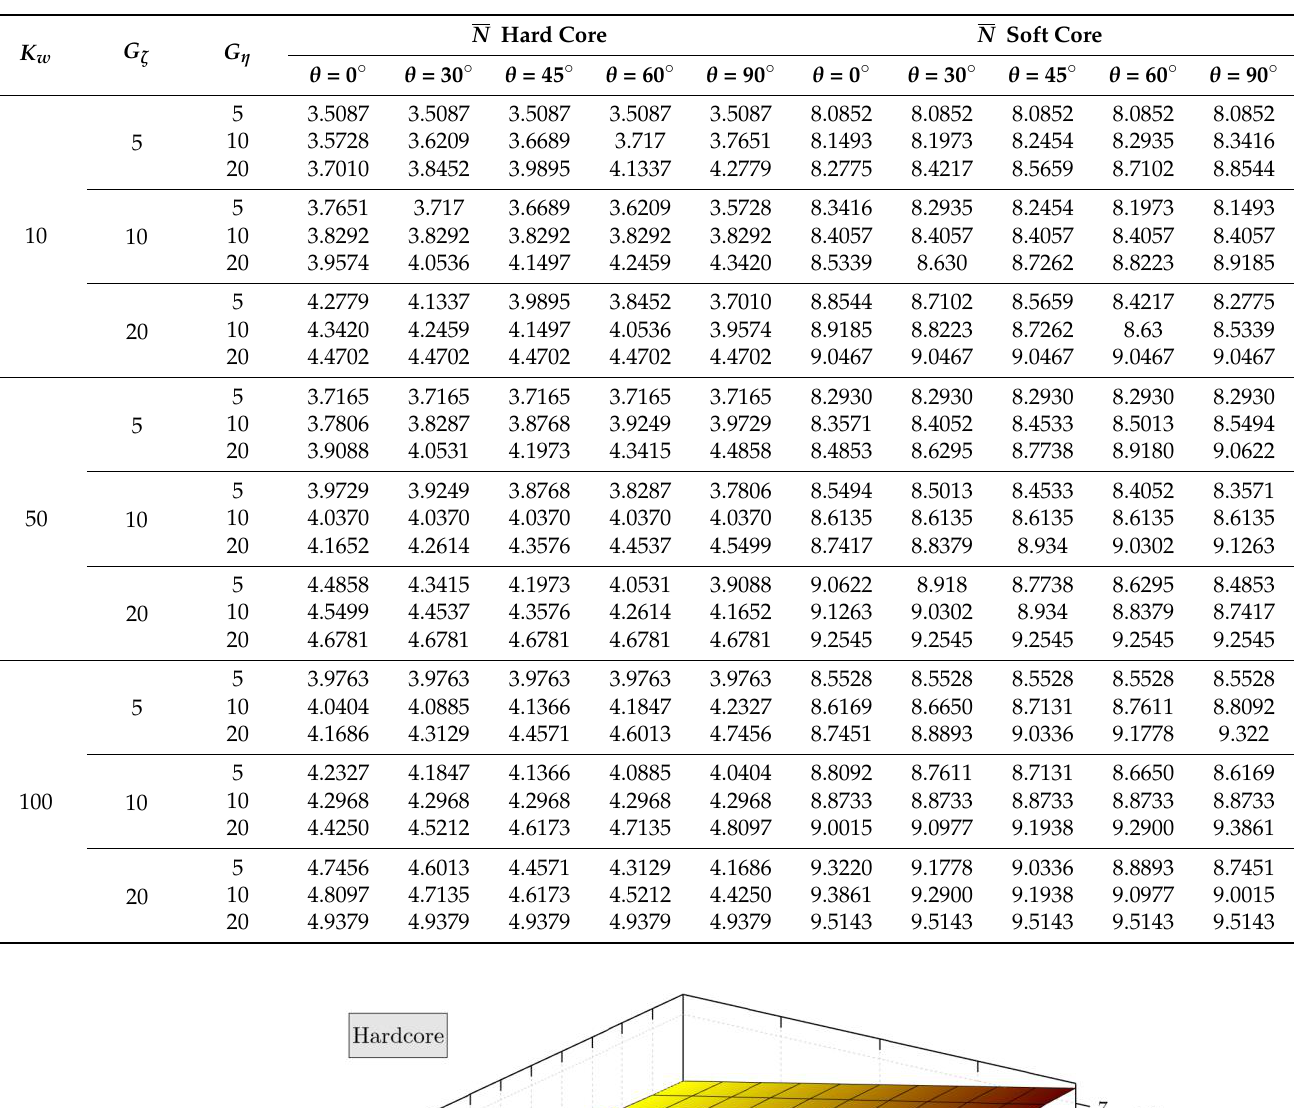
Table 8. Dimensionless critical buckling load N of tricoated FG-A shells rested on orthotropic